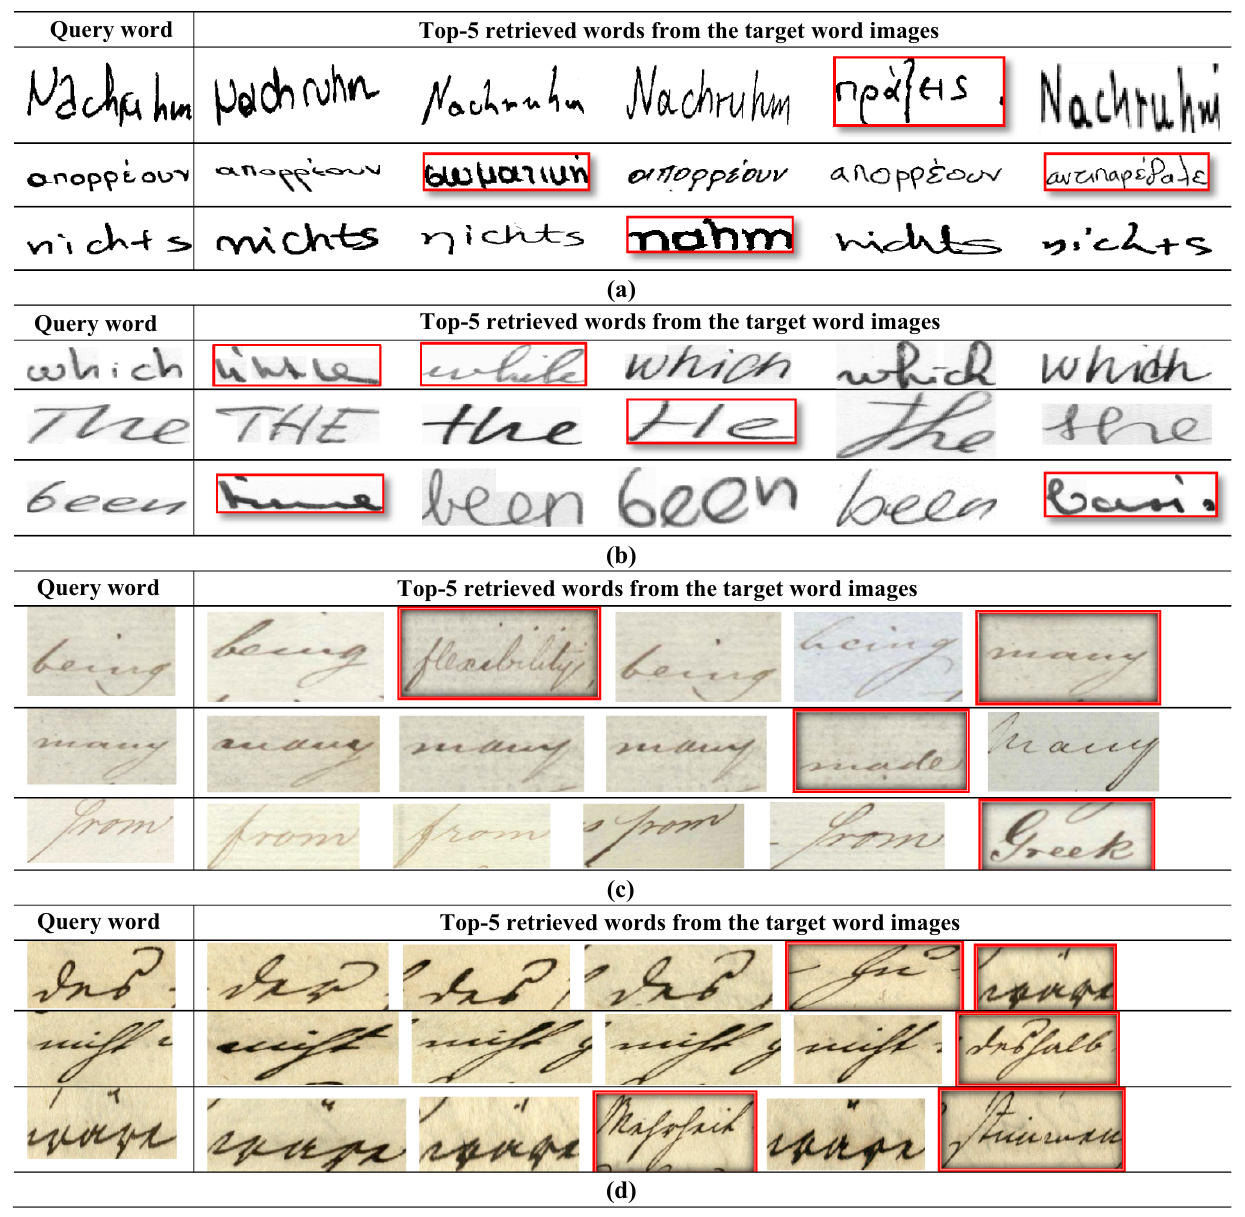
Fig. 13 Top-5 search results for three queries from a ICFHR 2014 H-KWS competition Modern dataset, b IAM dataset c ICFHR 2016